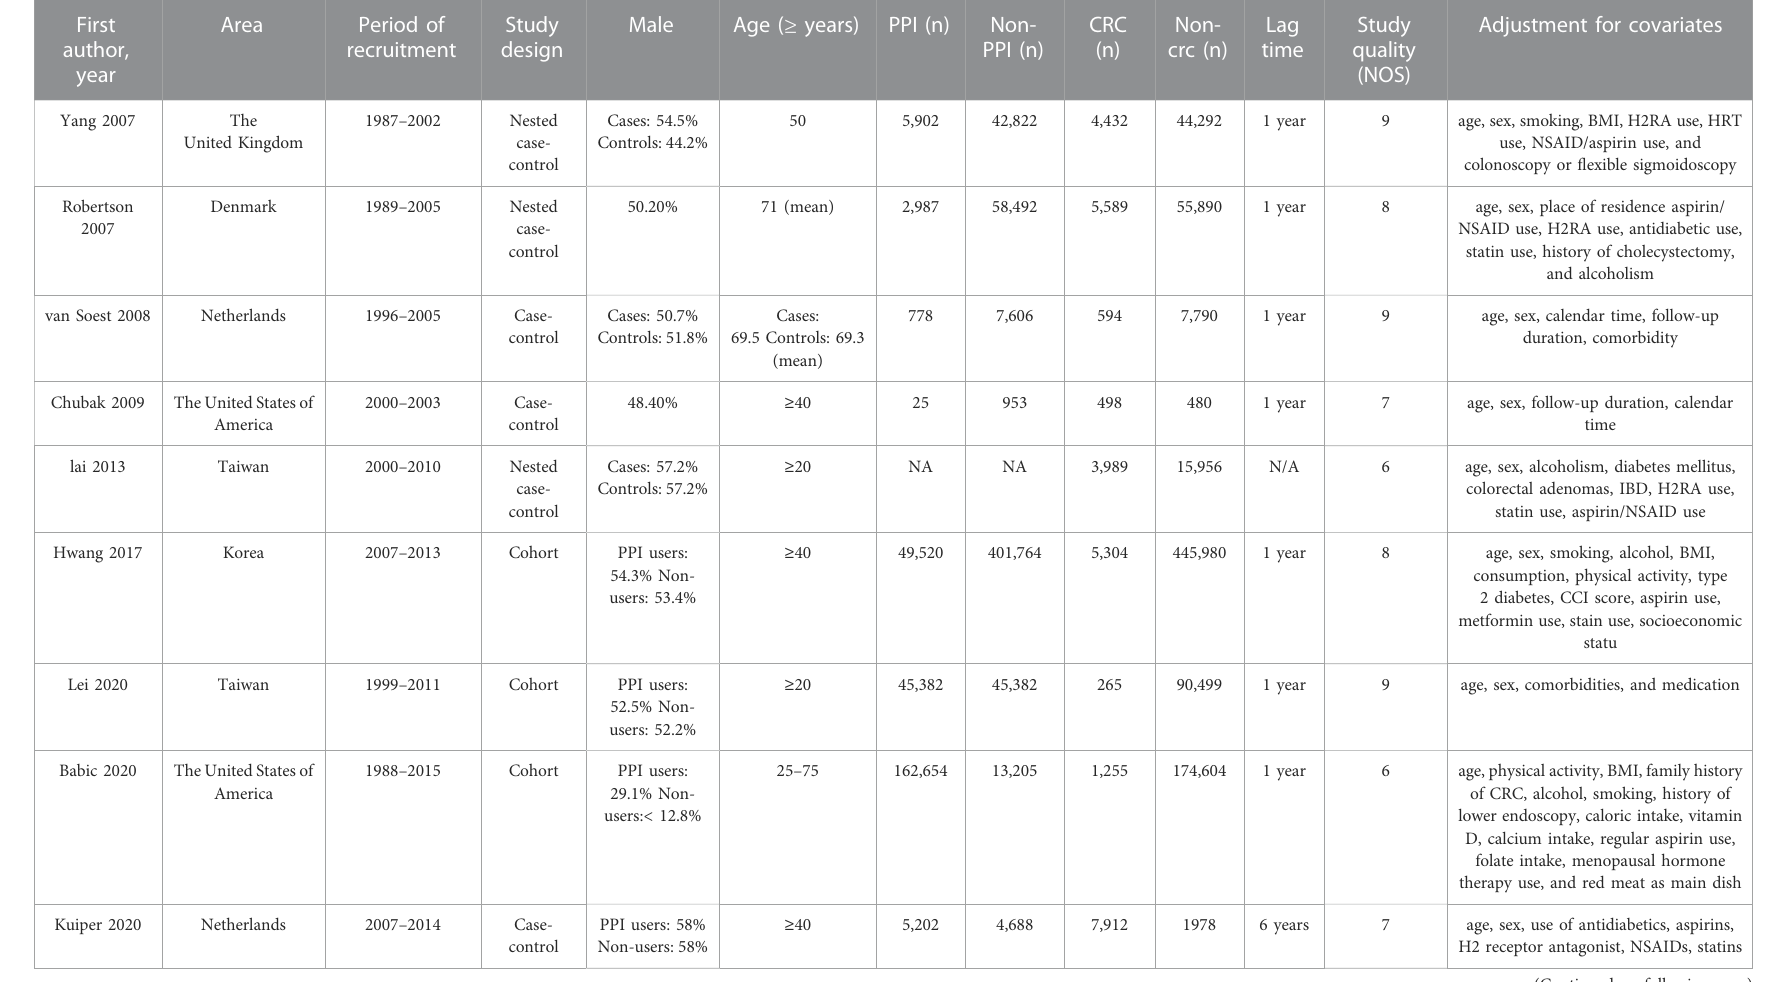
TABLE 2 Characteristics of the included studies on the use of PPI and risks of Colorectal